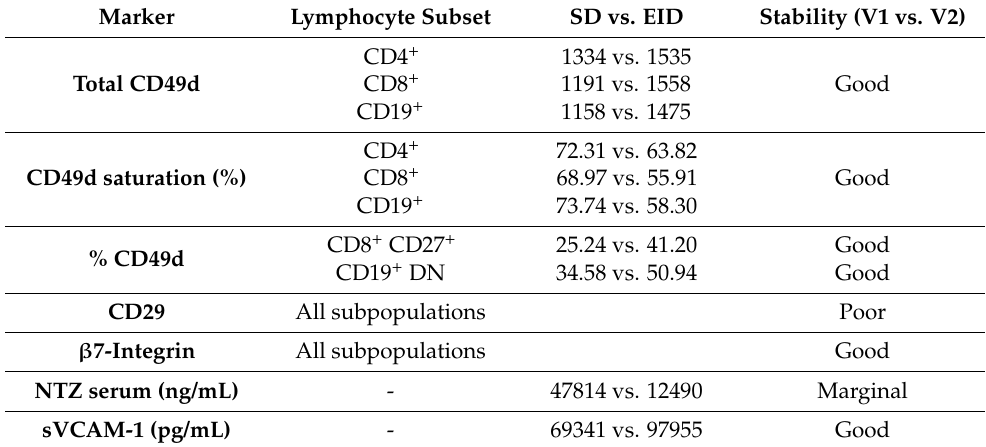
Figure 4. Representation of SD and EID groups in some CD4 + and CD8 + T lymphocytes, and CD19 + B lymphocytes subpopulations in RRMS patients under Natalizumab treatment in both first (V1) and second (V2) extractions. Percentage of expression of CD49d in ( a ) CD8 + CD27 + T lymphocytes and ( b ) CD19 + DN B lymphocytes. Each dot represents the percentage of expression for each marker regarding their parent population (CD4 + or CD8 + T lymphocytes, or CD19 + B lymphocytes populations) in the SD ( n = 8) or EID ( n = 21) groups. DN, Double Negative; EID, extended interval dosing; NTZ, natalizumab; SD, standard dosing. Ns: p > 0.05, * p < 0.05, ** p < 0.01. Table 2. Summary table of the most relevant cell-surface and serum markers